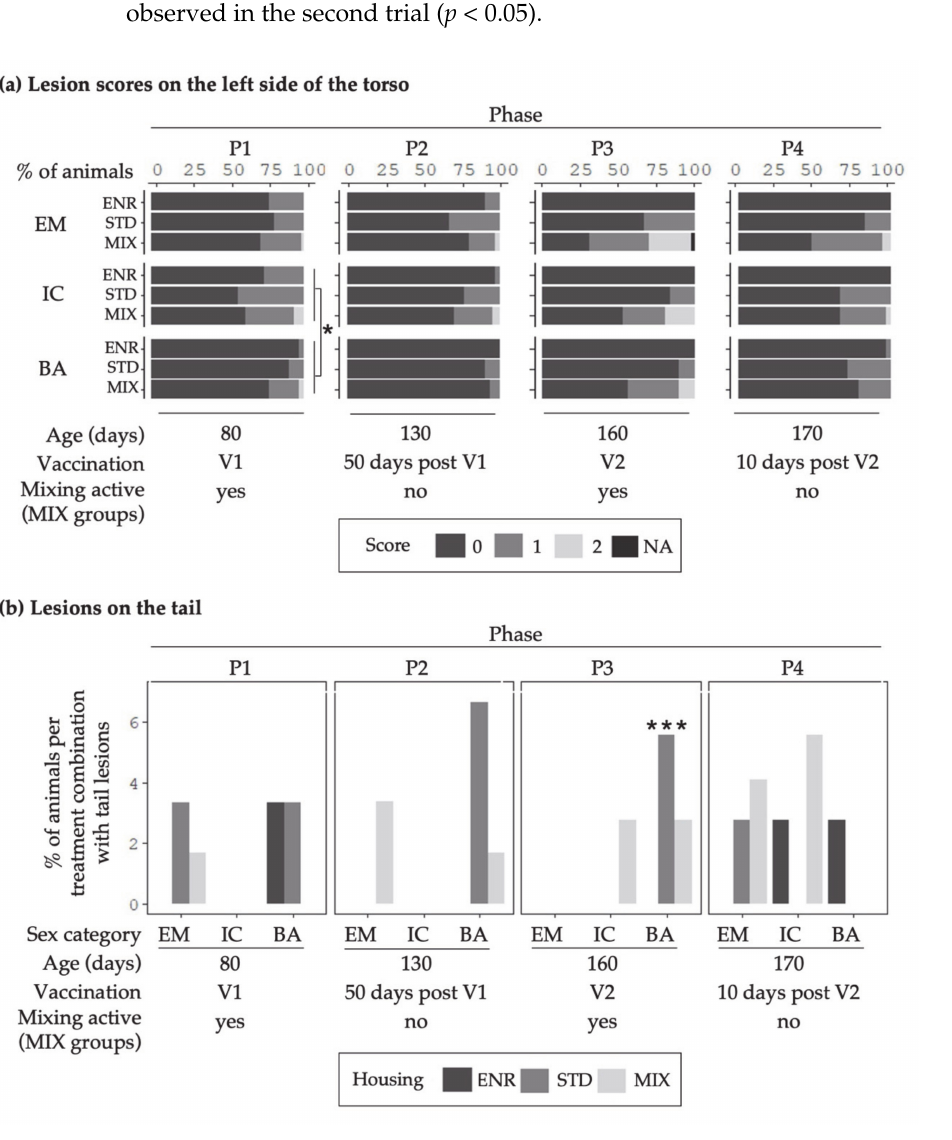
Figure 7. Percentages of animals of the treatment combinations (Sex categories: EM = entire males, IC = immunocastrates, BA = barrows; Housing environments: ENR = enriched, STD = standard, MIX = mixing) with ( a ) certain lesion scores on the left side of the torso and ( b ) lesions on the tail (score 1). Columns represent the data of animals in four different behavior observation phases (P1–P4). V1 represents phases before, and V2 after the second immunization of IC. The MIX pens were mixed in P1 and P3. Note: no mixing was done in STD and ENR at any time. Significant differences between treatment combinations are indicated by asterisks (*** p < 0.001, ** p < 0.01, * p <